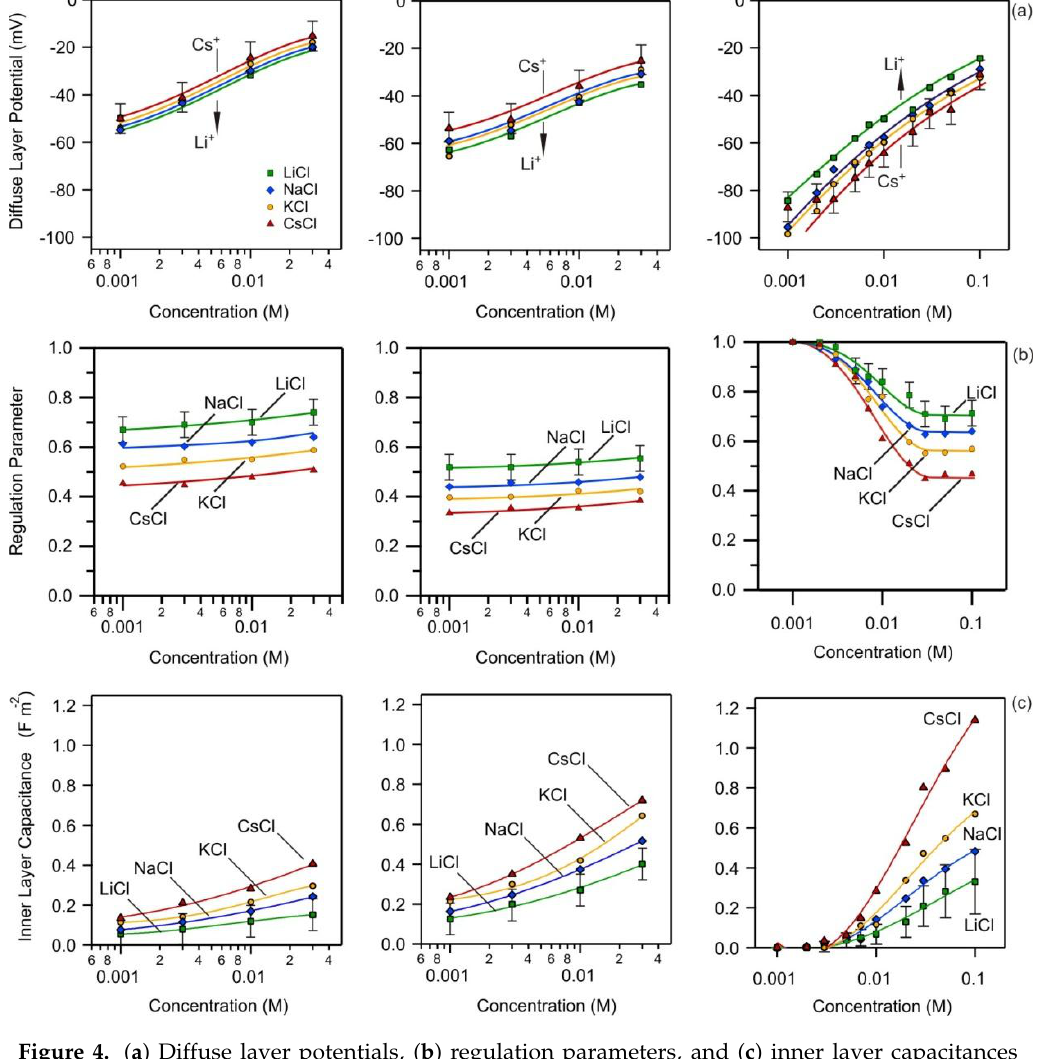
Figure 4. ( a ) Diffuse layer potentials, ( b ) regulation parameters, and ( c ) inner layer capacitances as a function of salt concentration extracted from the force measurements. The left column presents results for silica particles at pH 4, the middle column for sulfate latex at pH 4, and the right column shows the results for silica particles at pH 10. The measurements were done in LiCl, NaCl, KCl, and CsCl aqueous solutions. Lines are only eye-guides. Error bars are only shown for one set of data but are comparable for all sets.